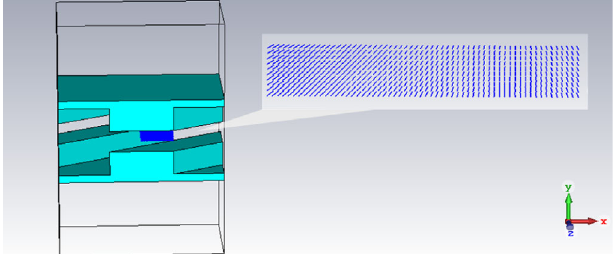
FIG. 6. Single cell of the tilted grating deflector structure and enlargement of kick integration curves array. The integrated kicks are displayed in Fig.